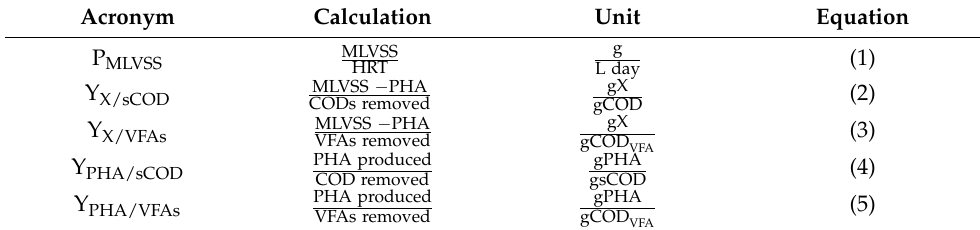
Table 1. The calculation for